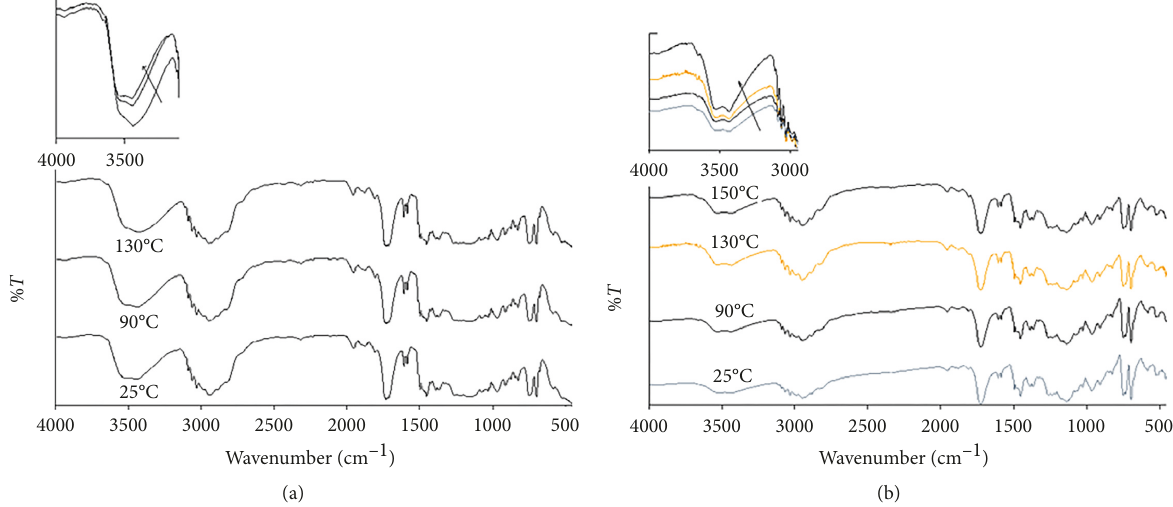
Figure 3: FT-IR spectra of (a) poly(DEAMSt0.49-co-BMA) and (b) poly(DEAMSt0.49-co-BMA)-Zn complex heated up to various temperatures.